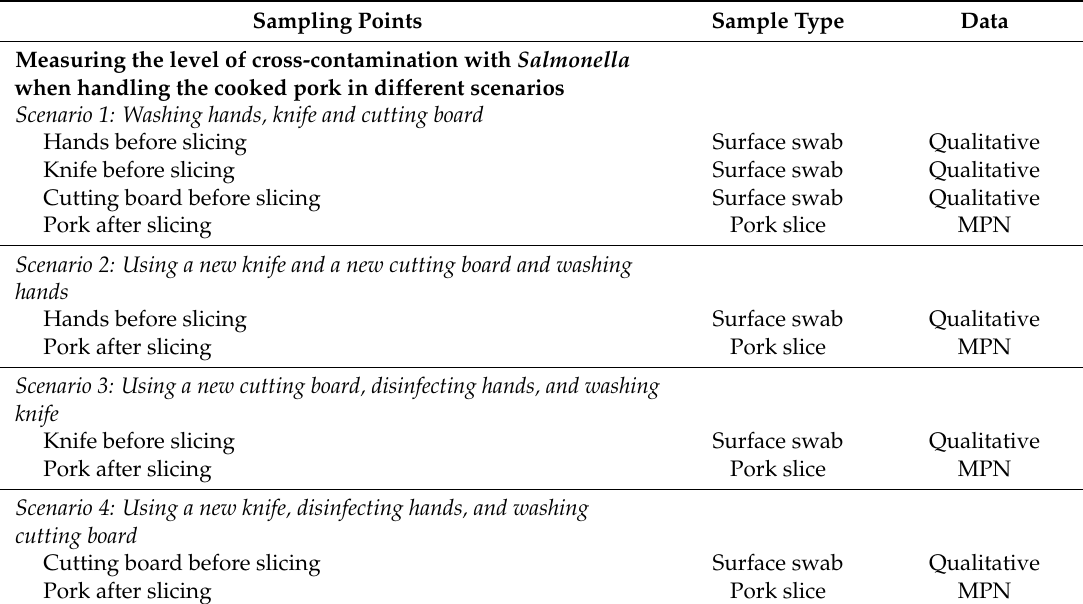
Table 1. Cont . Sampling Points Sample Type Data